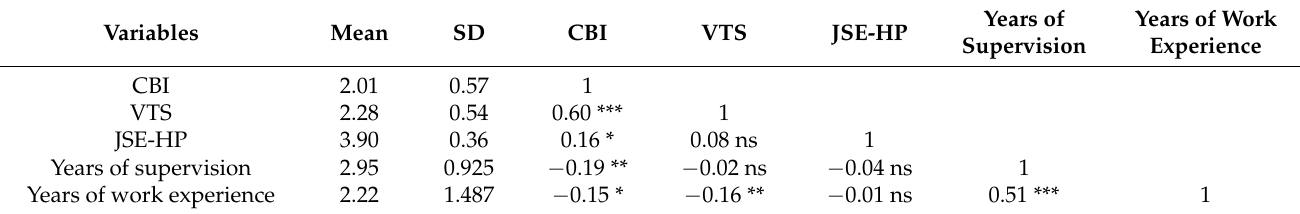
Table 2. Correlations between measured